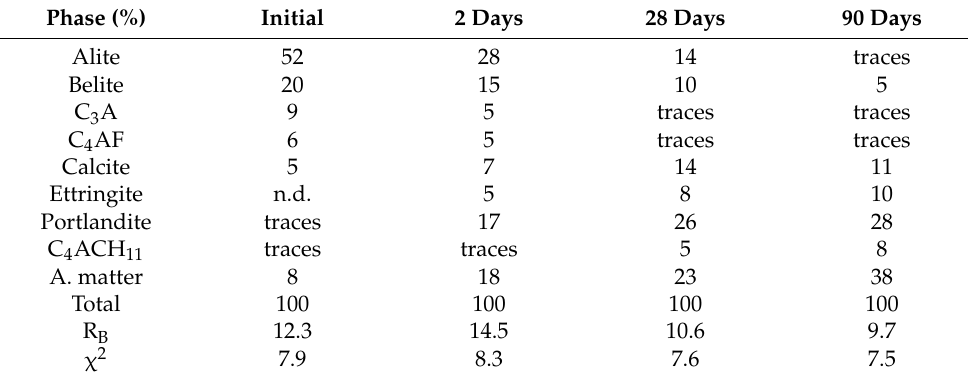
Table 5. Mineralogical composition of OPC paste